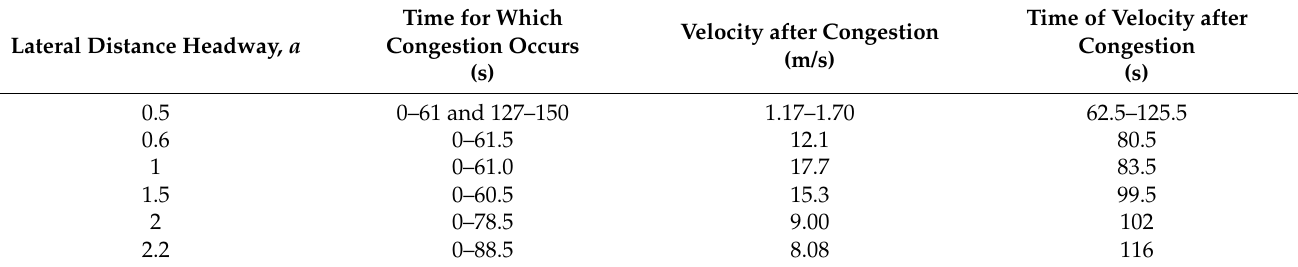
Table 6. Velocity and time for the proposed model during and after